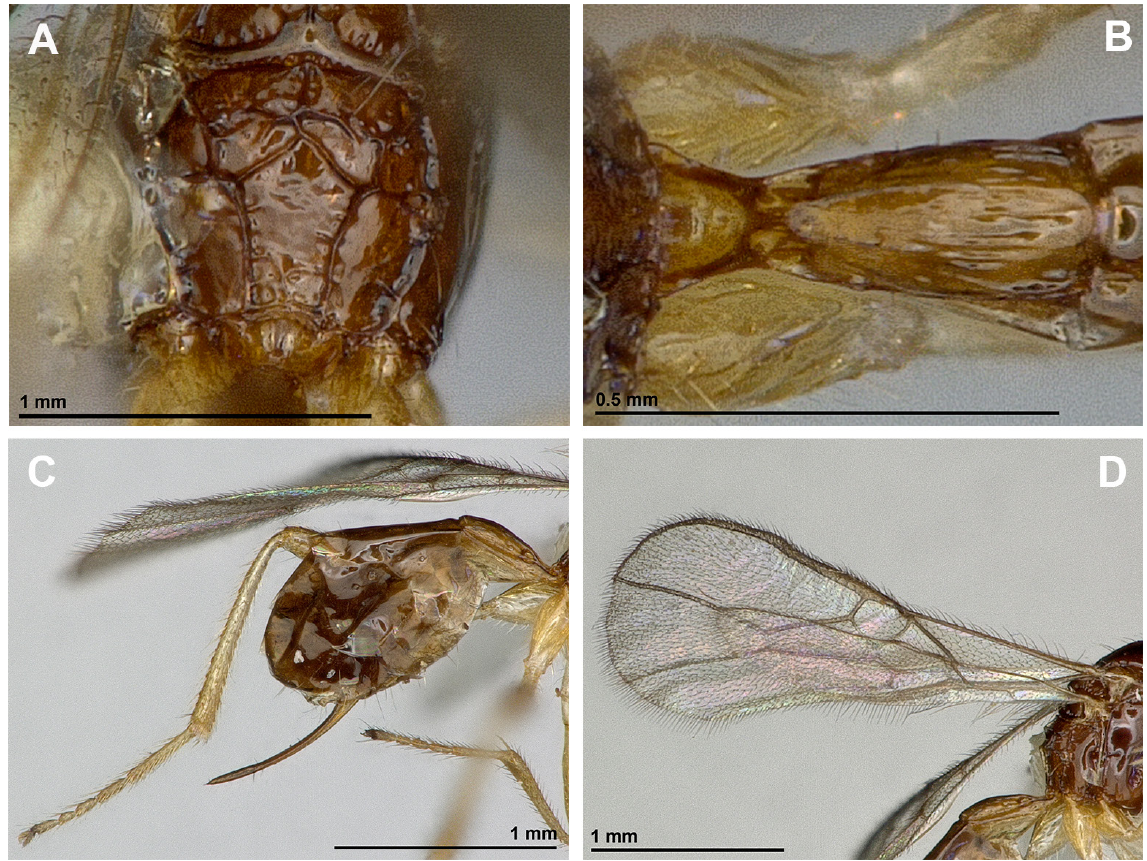
Fig. 4. Dinotrema plaumanni Peris-Felipo sp. nov. (♀). A . Propodeum, dorsal view. B . First metasomal tergite. C . Metasoma, hind leg and ovipositor, lateral view. D . Fore and hind